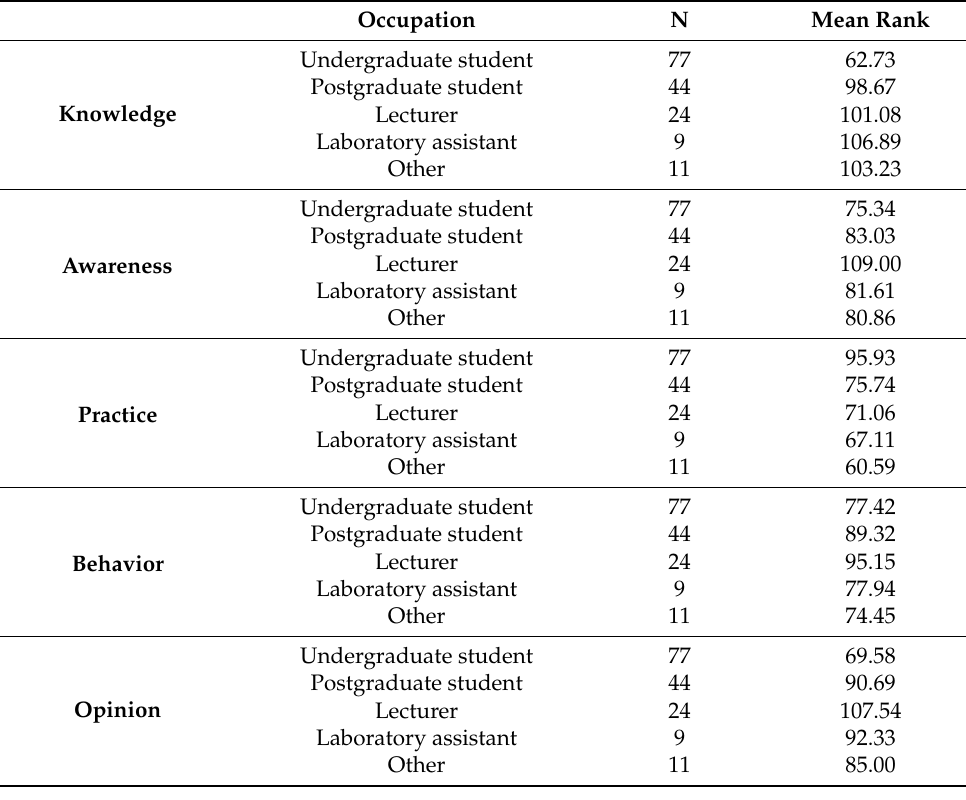
Table 7. Mean ranks of Kruskal–Wallis H test analysis for the laboratory users’ different occupations.